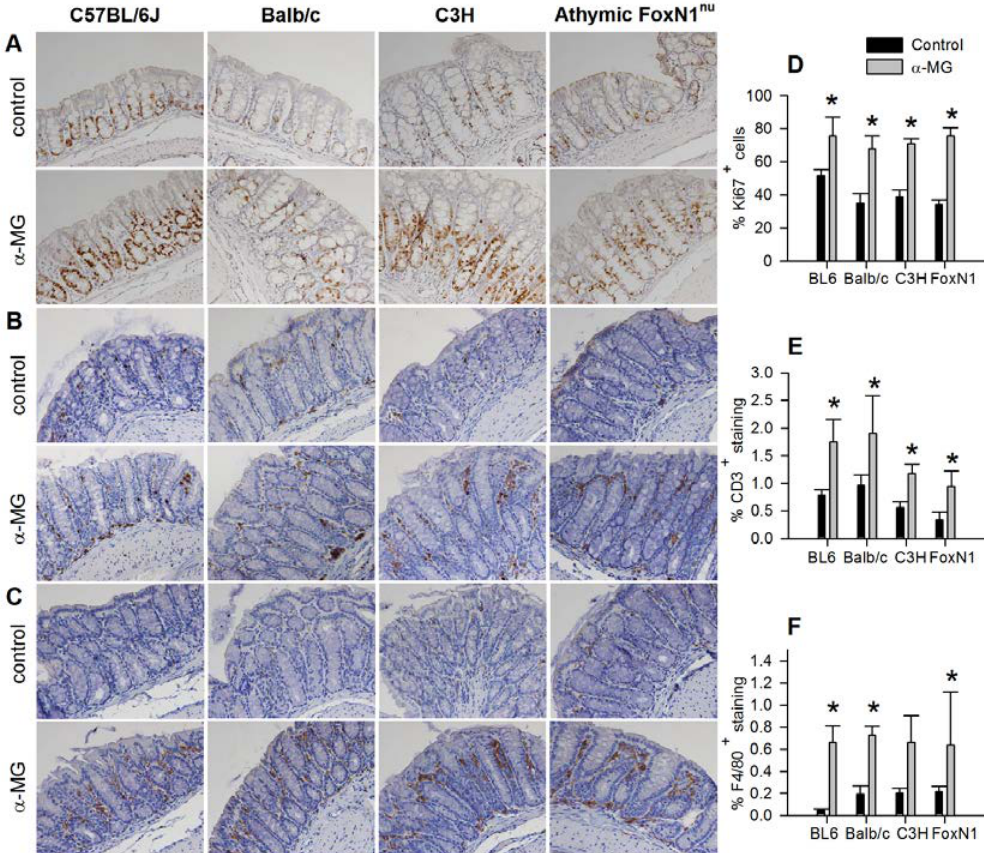
Figure 2. Induction of colonic epithelium hyperproliferation and infiltration of immune cells by dietary α-mangostin. Dietary α-mangostin induces a significant increase in Ki67 + ( A , D ); CD3 + ( B , E ); and F4/80 + ( C , F ) immunostaining in the mid colon of C57/BL6J, Balb/c, C3H and Athymic FoxN1 nu mice. * p < 0.05 against control group. Data are mean (±SD) for 5 mice per group for each strain fed either control diet or diet containing